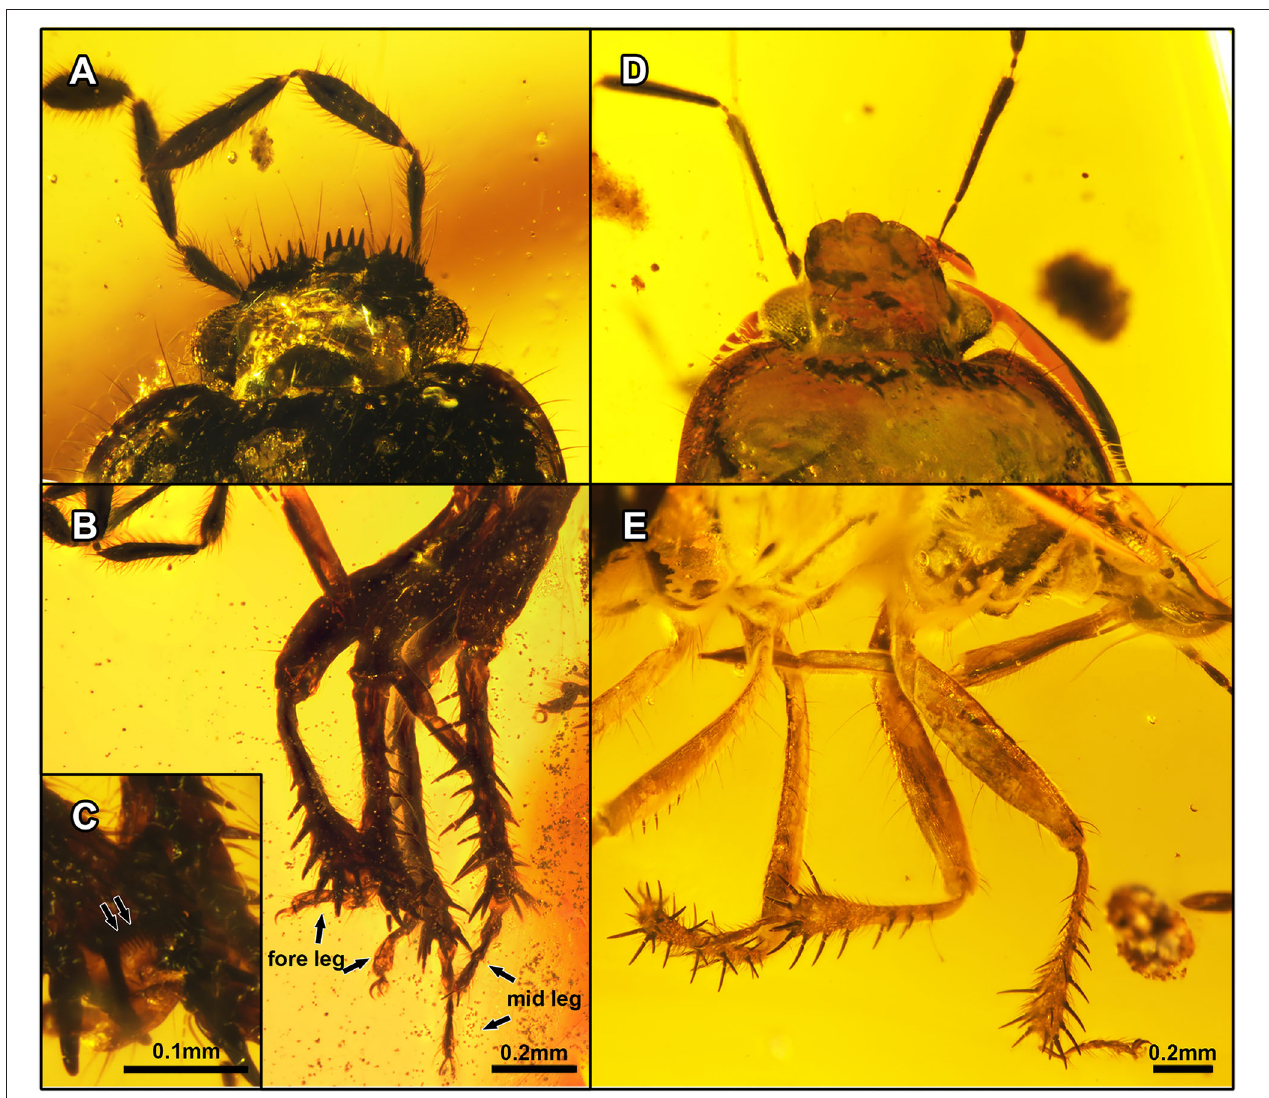
FIGURE 9 | Two different morphotypes in Burmese amber. Photograph of Acanthamnestus ovoideus gen. et sp. nov. in (A–C) . (A) Head in dorsal view. (B) Protibiae in left lateral view. (C) Detail of protibial comb. Photograph of Laevigemma lisorum gen. et sp. nov. in (D,E) . (D) Head in dorsal view. (E) Protibiae in left lateral view. Scale bars: A = B = 0.2mm; C = 0.1mm; D = E = 0.2mm.